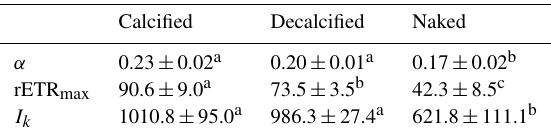
Figure 4. The non-photochemical quenching (NPQ) of calcified and naked cells of E. huxleyi grown under indoor conditions. Different letters represent significant differences among the light levels. Dif- ferent horizontal lines represent significant differences among the different type